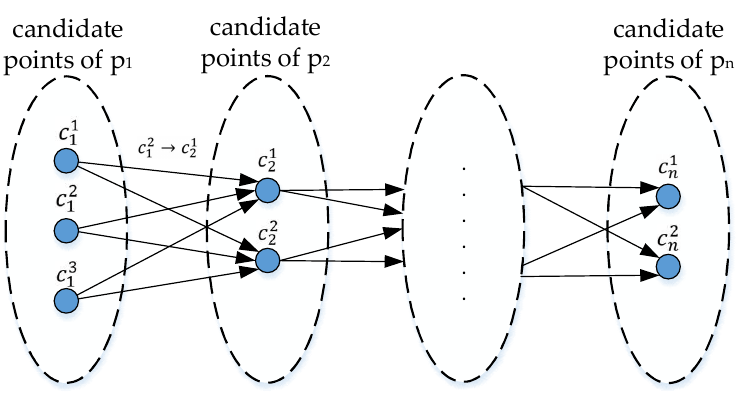
Figure 7. Candidate graph composed of candidate points and local candidate paths. Each candidate point has an observation probability, and the probability from the previous candidate point to the current candidate point is expressed as a transition probability.